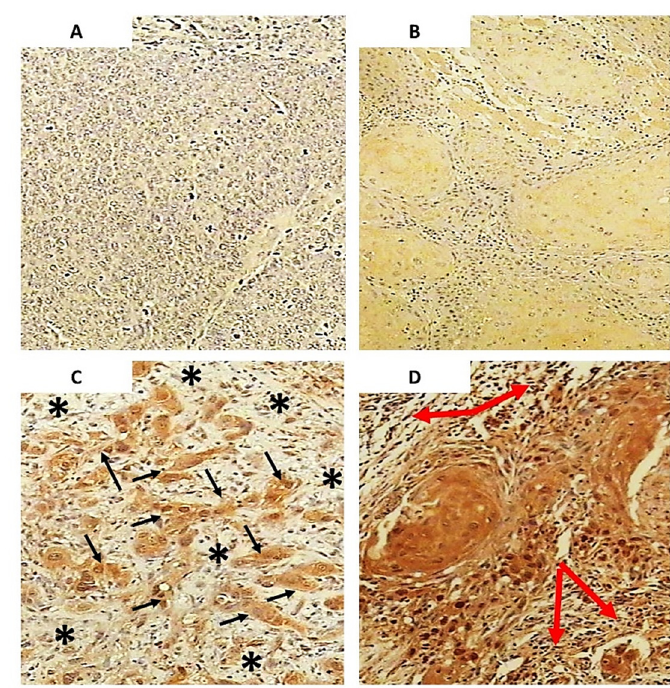
Figure 2. The immunohistochemical appearance of HNE in squamous cell carcinoma of the oropharynx. ( A ) Control staining without monoclonal antibody against HNE-protein adducts (consequently there is no brown chromogen reaction of DAB). ( B ) The appearance of the HNE-modified proteins mostly in cytoplasm of tumor cells of carcinoma grade I expressed at low staining intensity presented as yellow / light brown color (low magnification). ( C ) The appearance of the HNE-modified proteins carcinoma of the grade III mostly in cytoplasm and in some nuclei of tumor cells present as low to moderate intensity (some examples are indicated by small black arrows). Surrounding stroma is negative for HNE (indicated by asterisk), while chronic inflammatory cells, presented as dark spots, show presence of HNE (high magnification). ( D ) The appearance of HNE-modified proteins in another tumor of grade III but with moderate to high intensity of immunostaining. Surrounding stroma and chronic inflammatory cells (indicated by big red arrows) also show the presence of HNE.